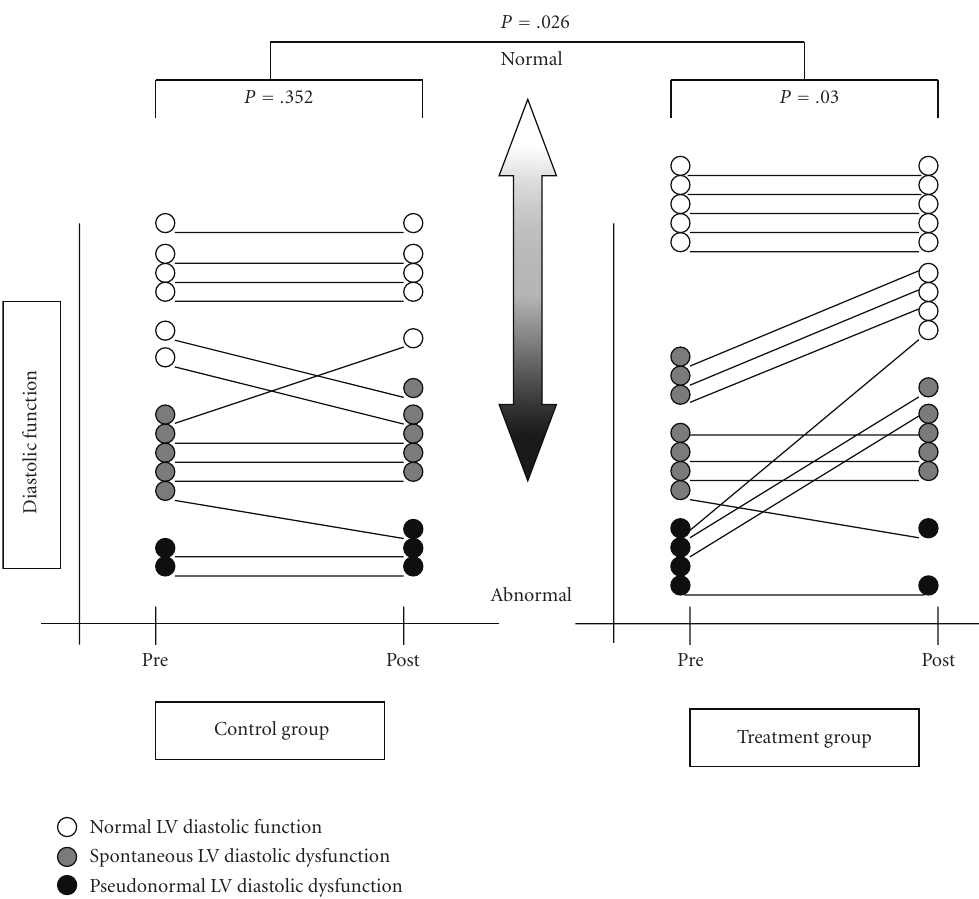
Figure 1: Changes in left ventricular (LV) diastolic function in both groups pre and